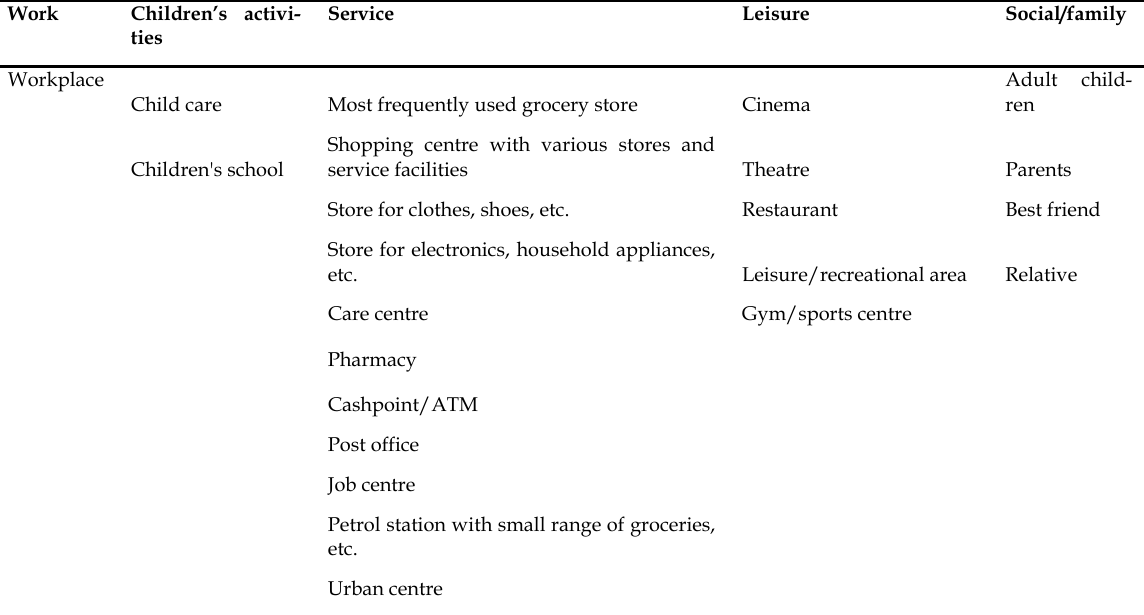
Table 1. Destinations in the